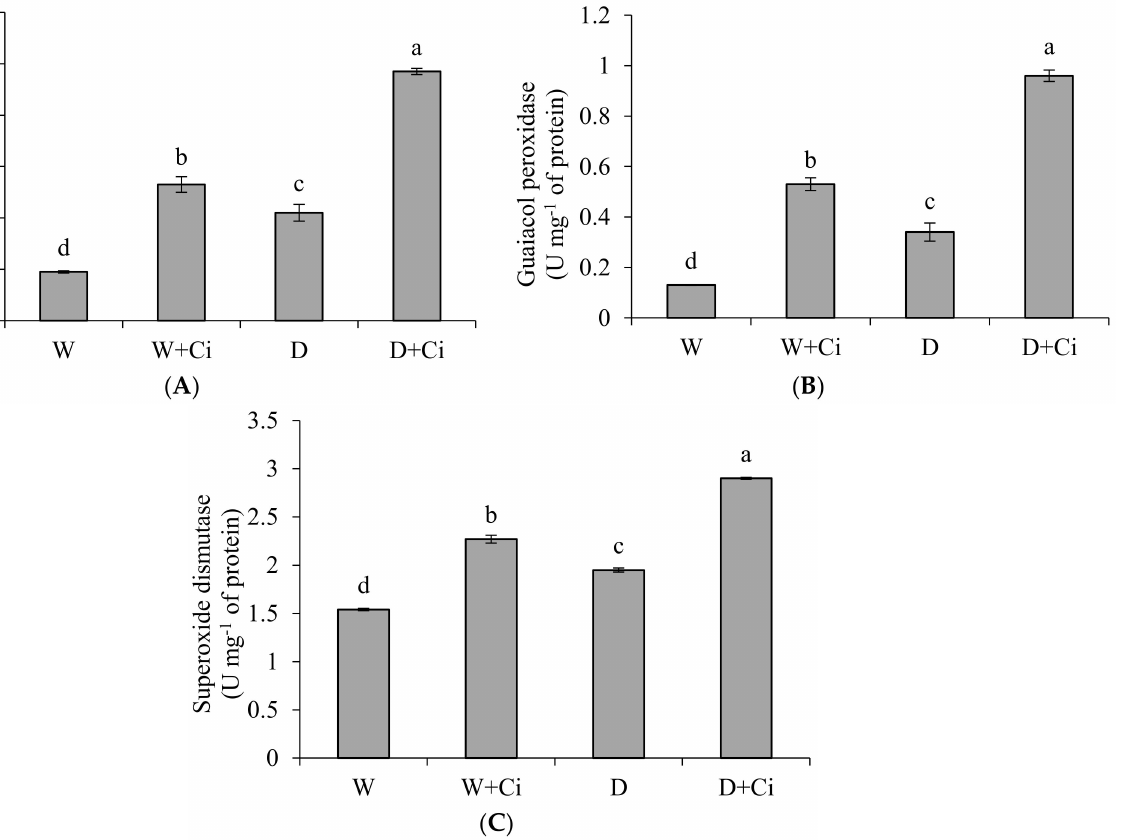
Figure 3. ( A ) Catalase; ( B ) guaiacol peroxidase and ( C ) superoxide dismutase activity of Calendula officinalis after foliar application of chitosan (7.5 mg L − 1 ) weekly at 100% and 60% FC. Letters above the bars represent significant differences at p < 0.05 according to LSD test. W, normal conditions (100% FC); W + Ci, chitosan under normal conditions; D, drought stress without chitosan (60% FC); D + Ci, drought stress with chitosan (each mean consists of 3